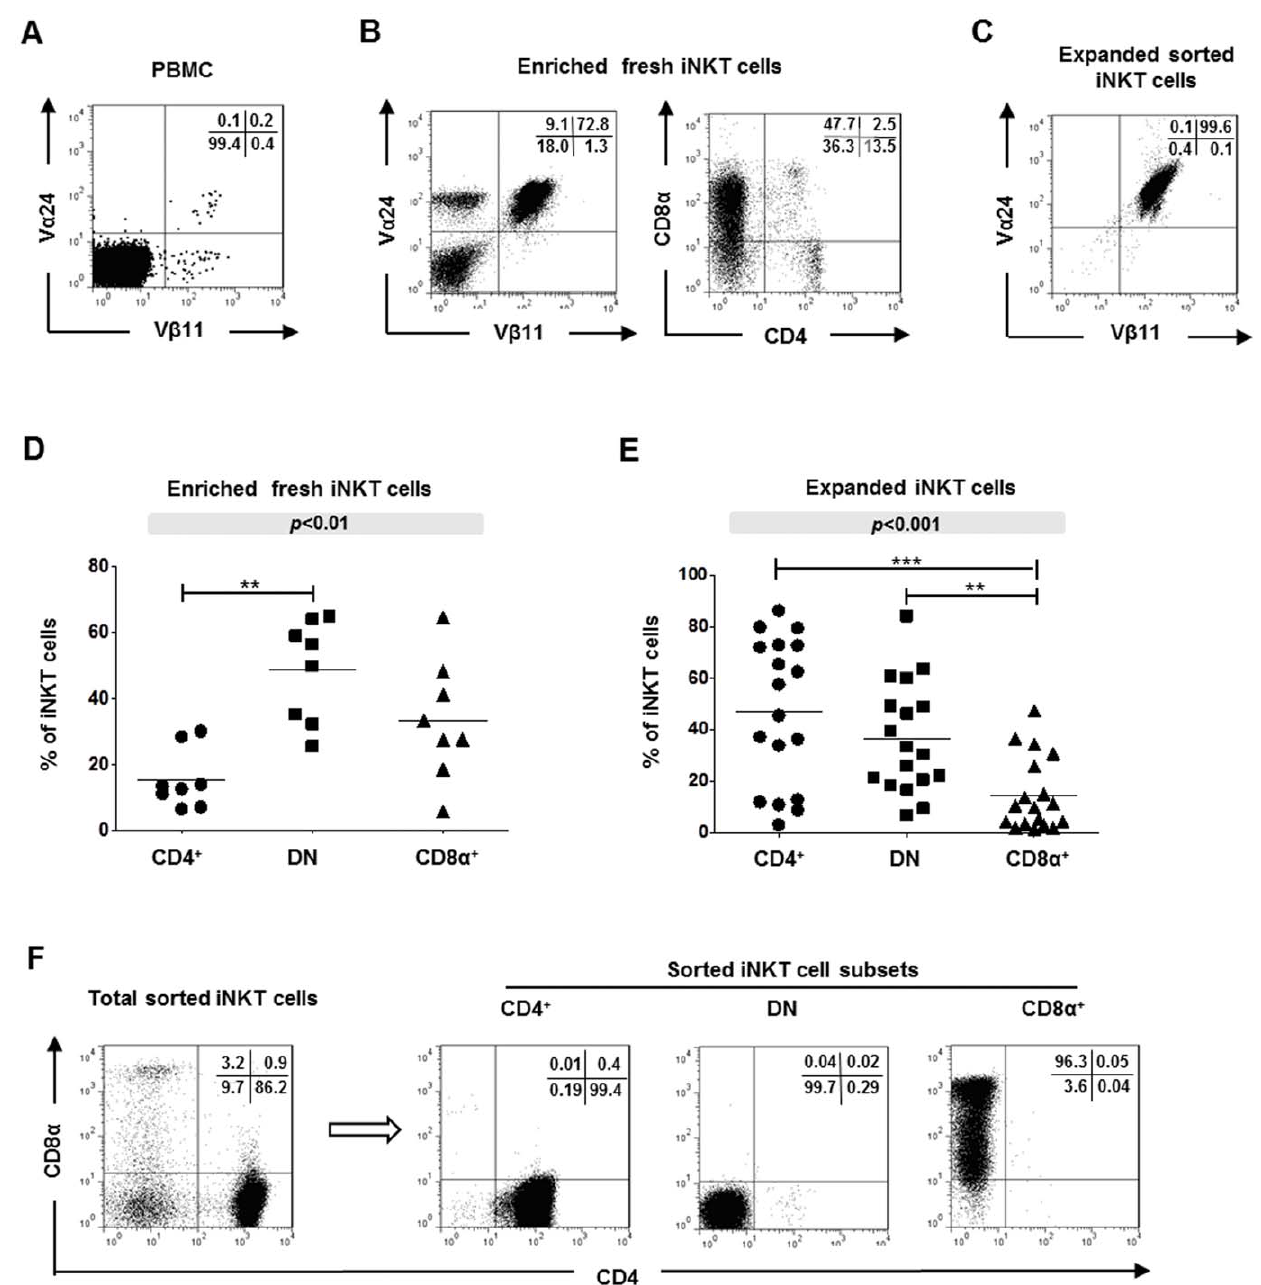
Figure 1. Isolation and expansion of human peripheral blood iNKT cells and analysis of CD4 and CD8 a expression. A, Representative flow cytometry dot plot showing V a 24 and V b 11 TCR chain expression by freshly-isolated human PBMC. B, V a 24 and V b 11 TCR chain expression by PBMC after enrichment using anti-iNKT cell magnetic beads but without expansion (left panel) and CD4 and CD8 a expression by gated V a 24 + V b 11 + cells (right panel). Plots are representative of PBMCs from 8 healthy donors. C, V a 24 and V b 11 TCR chain expression by an expanded sorted iNKT cell line. Numbers in plots show percentages of cells in each quadrant. D and E, Distribution of CD4 + , CD8 a + and DN cells among freshly-isolated iNKT cell lines from 8 randomly obtained healthy donors (D) and among expanded iNKT cells from 20 donors (E). Horizontal lines show means; p values in shaded boxes show comparisons of CD4 + , CD8 a + and DN iNKT cell frequencies using the Kruskal-Wallis test; asterisks indicate significant differences between individual groups (indicated by bars) using post hoc Dunn’s multiple comparison tests; ** p , 0.01; *** p , 0.001 . F, Flow cytometric sorting of purified CD4 + , CD8 + and DN iNKT populations from polyclonal iNKT cell lines.